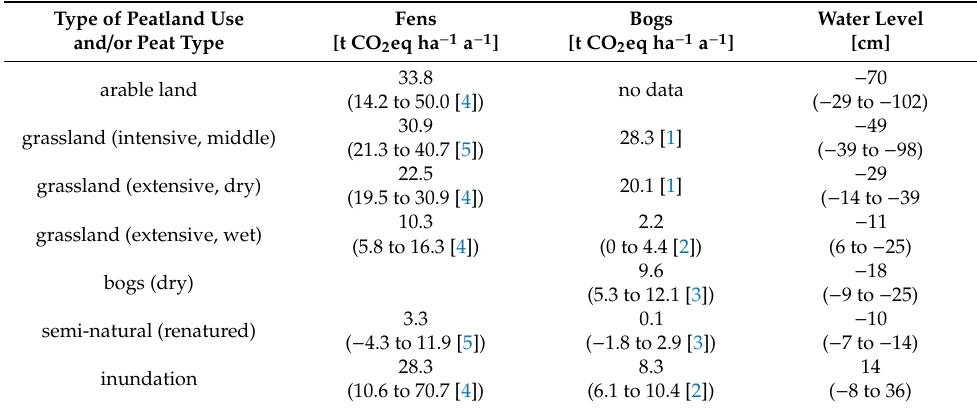
Table 1. Greenhouse gas (GHG) balances by type of land use and peat type (average values (range [sample size])), own illustration, according to Drösler et al.